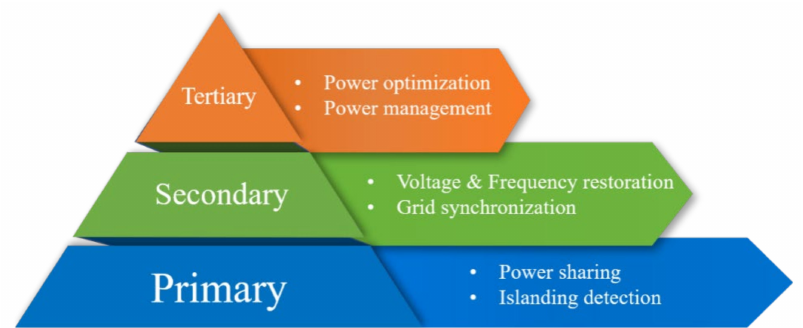
Figure 2. Hierarchical control with respective obligations for each